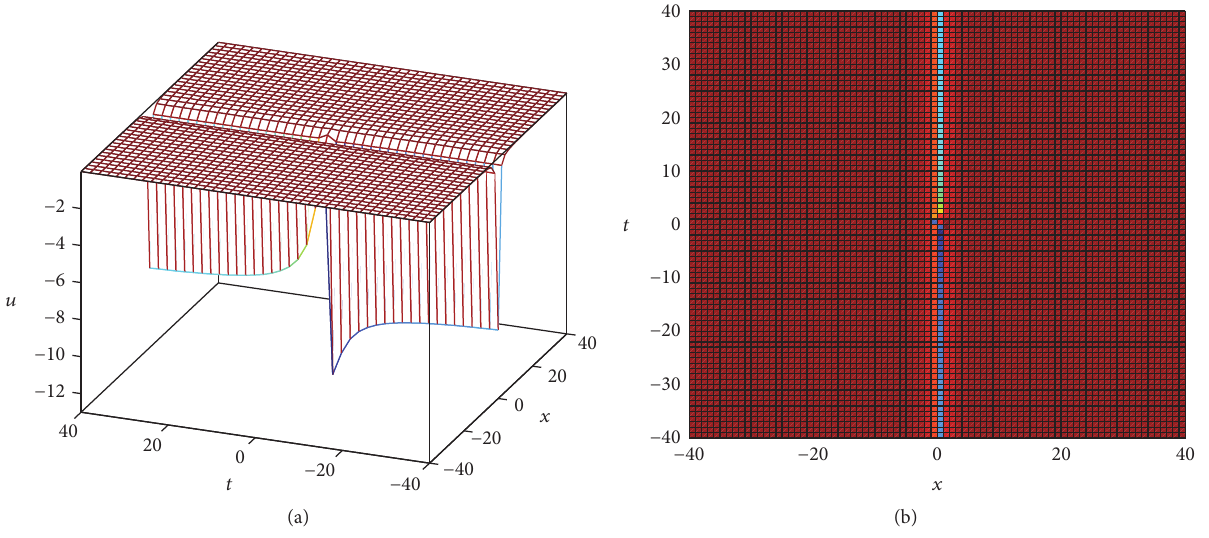
Figure 1: Pictures of (18): 3D plot (a) and density plot (b).